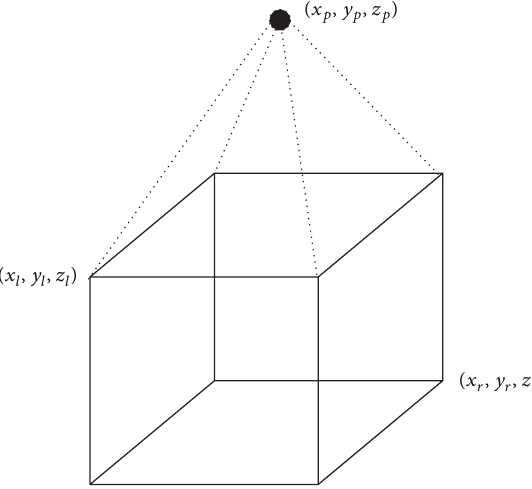
Figure 1: Construction of a prism of densities and its calculation with respect to an observation grid.